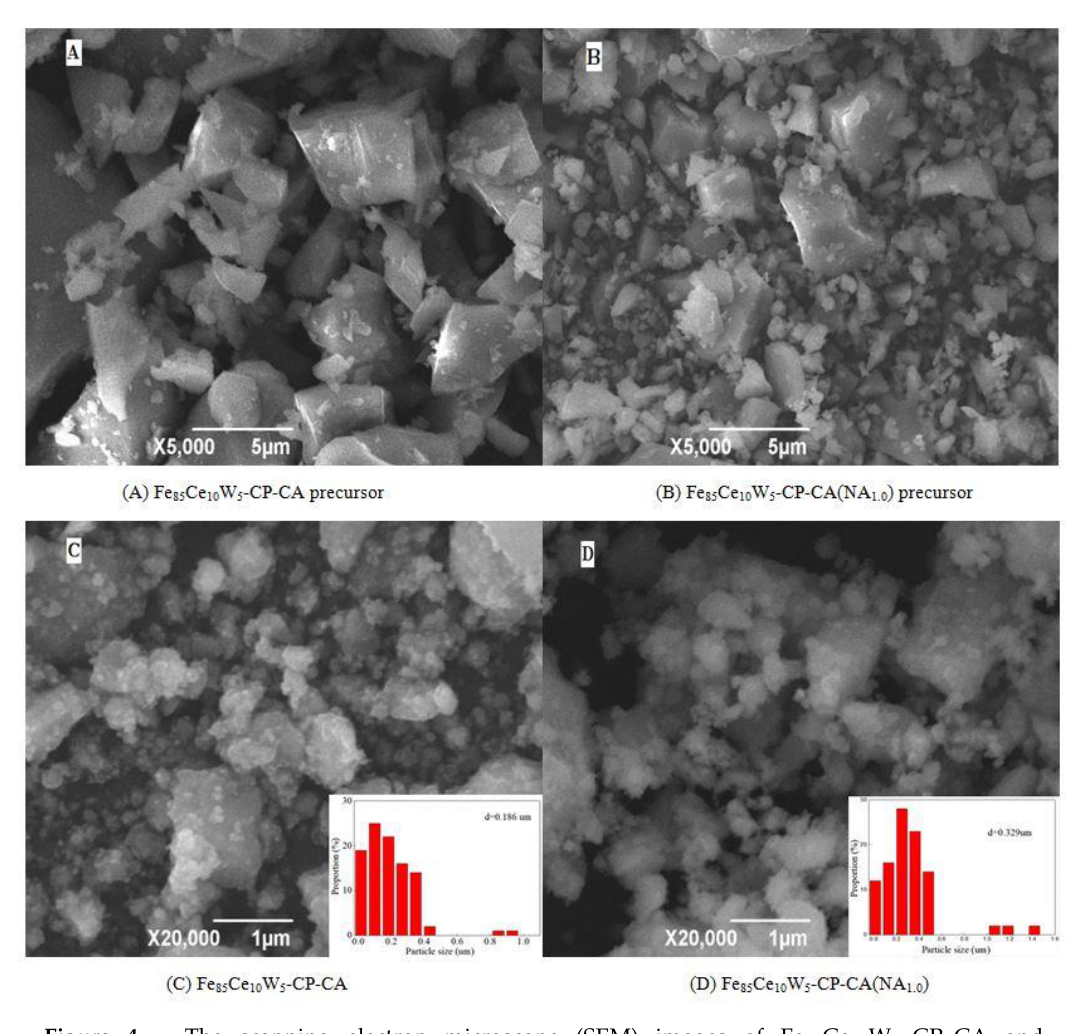
Figure 4. The scanning electron microscope (SEM) images of Fe85Ce10W5–CP–CA and